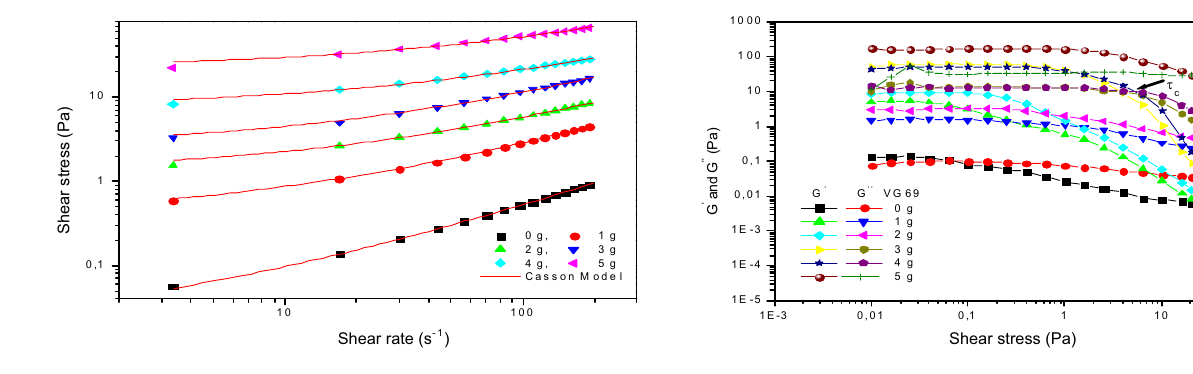
Fig. 5 Shear stress as a function of shear rate at different quantities of VG69. The solid lines correspond to the curve fitting to Eq. 2